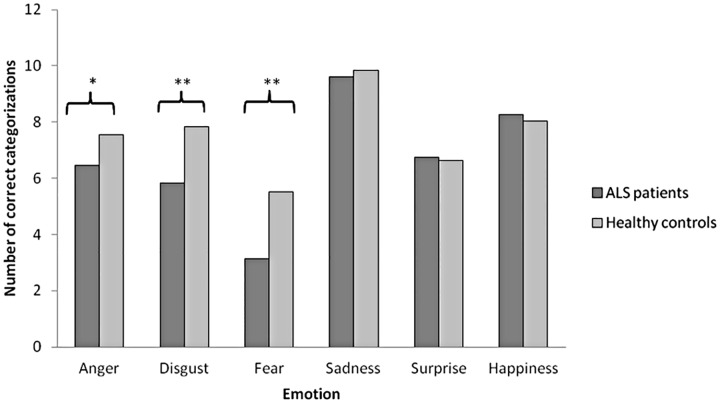
Number of correct categorizations of facial emotion expressions.* indicates statistical significance with p<0.05 and ** indicates statistical significance with p<0.01 between patients (n = 30) and healthy controls (n = 29) in a two-sample t-test.